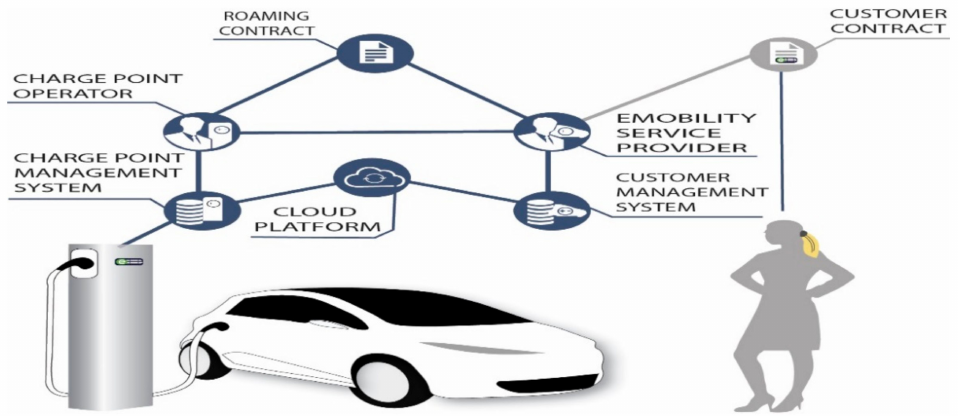
Figure 7. EV charge payment roaming—key elements